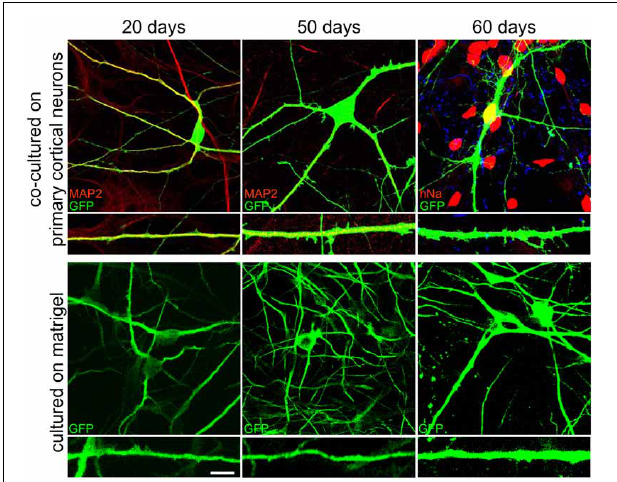
FIGURE 7 | Morphological comparison of neurons obtained with different differentiation protocols. The panels show representative images of neurons and dendrites of hNP-derived neurons which have been differentiated by co-culture on E18 rat primary cortical neurons or on matrigel after 20, 50, and 60 days in